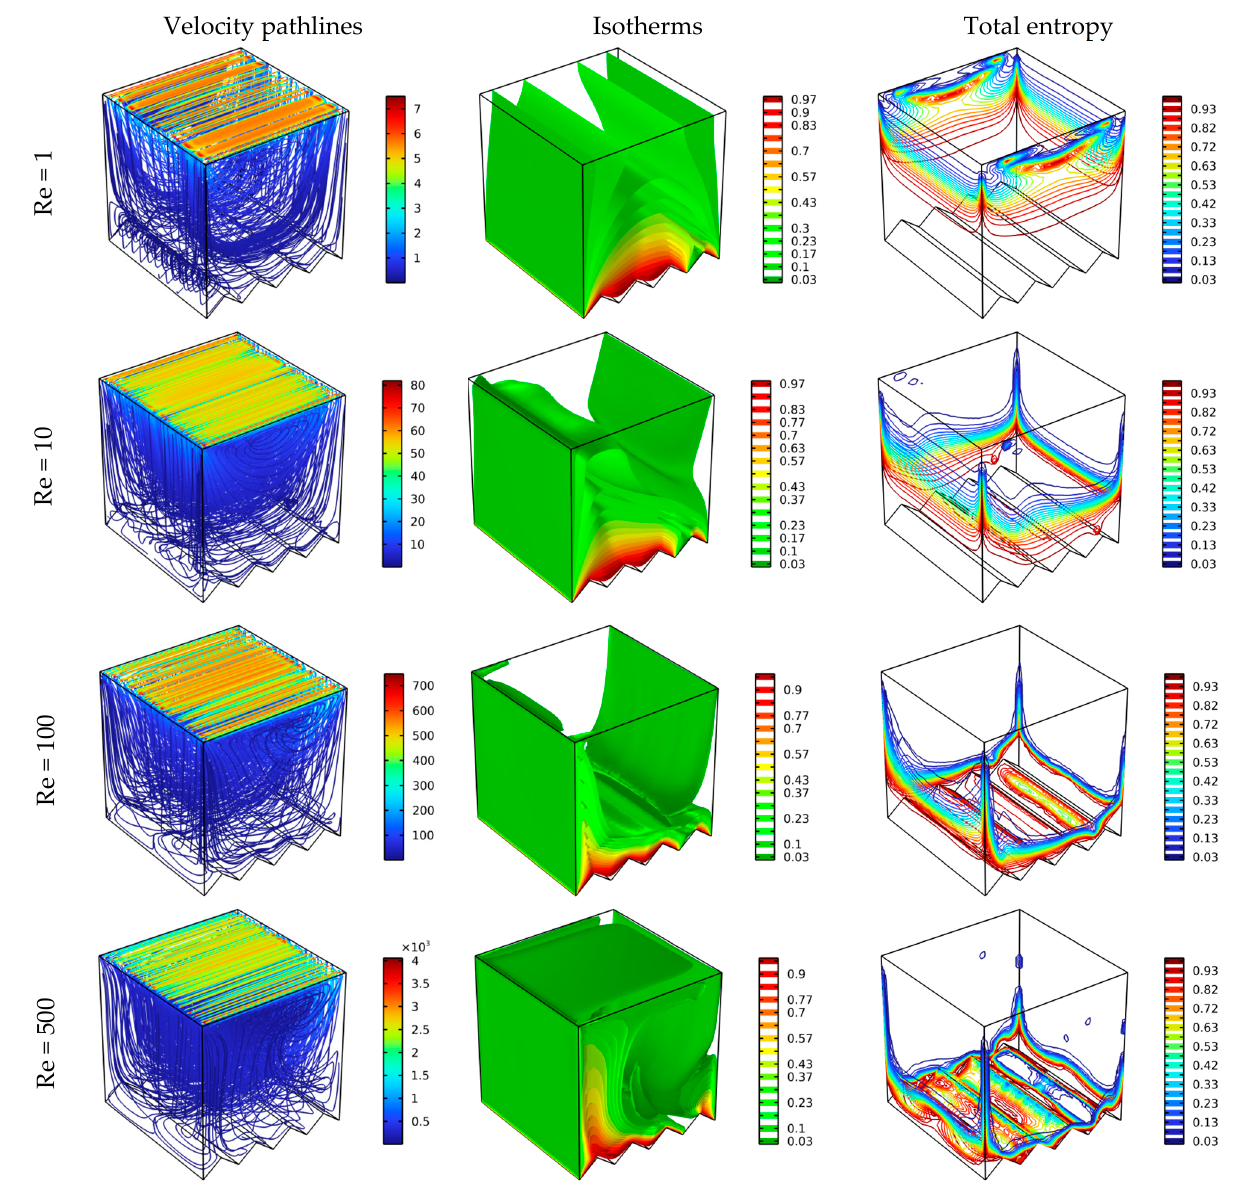
Figure 6. Distribution of velocity pathlines, isotherm, and total entropy for different Re at different scenarios where Ha = 0, Da = 10 − 2 , and ϕ = 0.04.